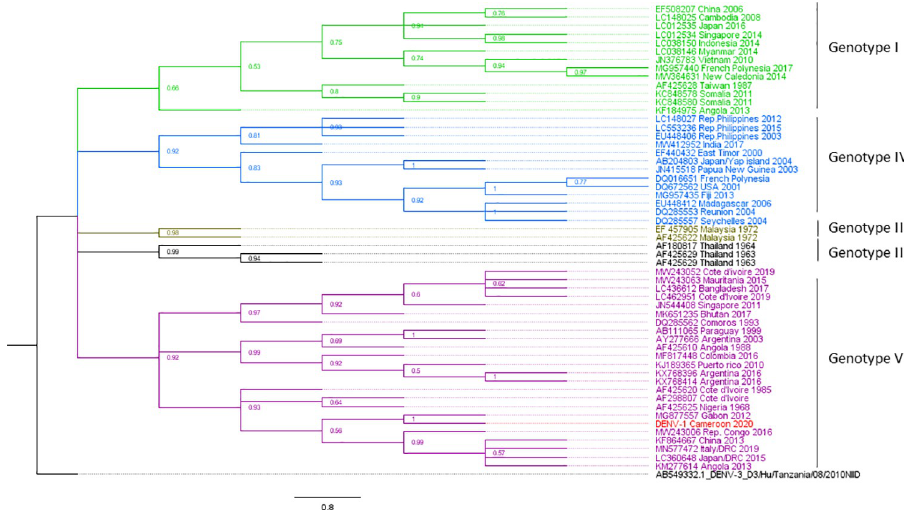
Fig 2. Dengue virus 1 phylogenetic tree built with a 721 bp fragment of the envelope gene. The maximum likelihood tree was built using the TN-93 +G+I model. Each DENV genotype is represented by a single colour. The sequence from this study is highlighted in red. The tree node value represented the bootstrap expressed in decimal. Dengue virus 3 from Tanzania was used as outgroup. DENV-1 from Cameroon formed a cluster with the Gabonese trains within the genotype V.